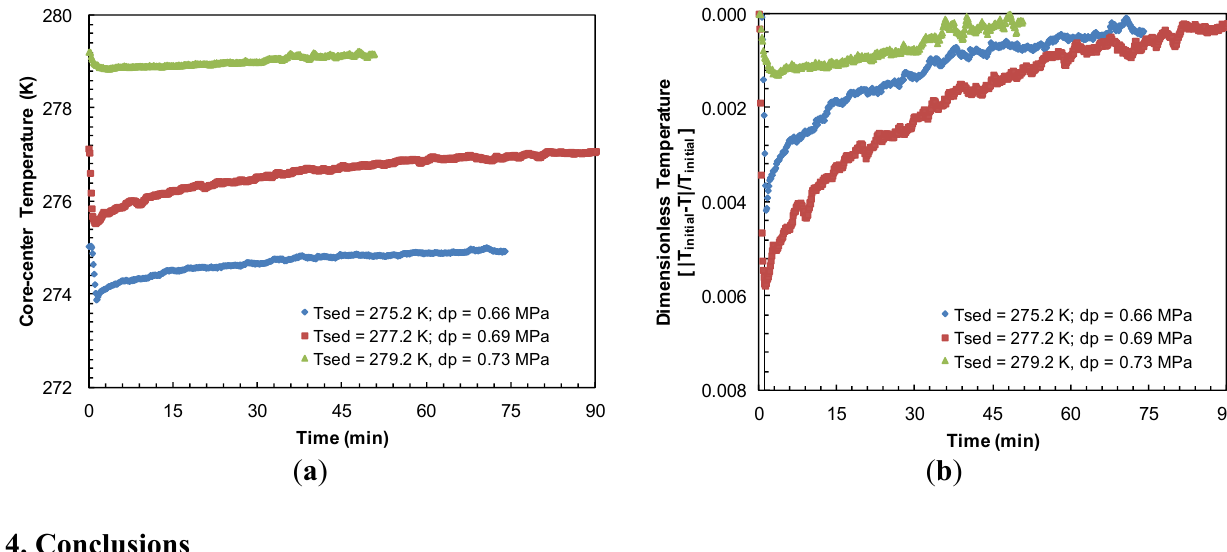
Figure 10. ( a ) Thermocouple response at half-radius of the sand-pack during dissociation with similar pressure drops below hydrate equilibrium pressure at sediment temperatures of 275.2, 277.2 and 279.2 K in Experiments 4, 3 and 5, respectively; ( b ) Dimensionless sediment temperature change [|I -T|/I ] against time for similar pressure drops for dissociation nitial nitial from sediments at 275.2, 277.2, and 279.2 K. Experiments 3–5 were performed at a constant confining pressure of 10.44